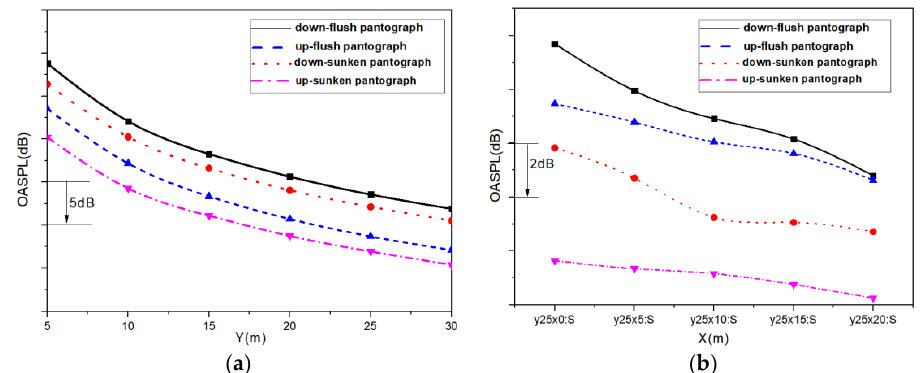
Figure 18. Comparison of OASPL at different distances of pantographs with different configuration bases: ( a ) with pantograph as reference position, OASPL at different vertical distances from center line of track in horizontal plane; and ( b ) OASPL of up- and down-pantograph with different configuration bases at different monitoring points along moving direction of train.